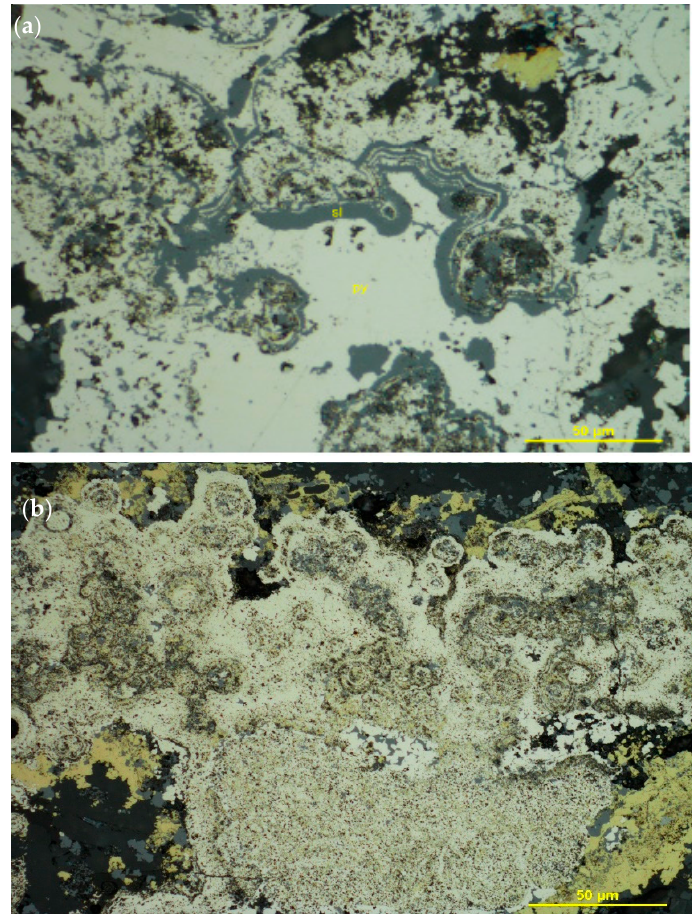
Figure 3. Very fine-grained crystals of pyrite (py) are intergrown with the sphalerite (sl) and define crustiform and layered intergrowths ( a ). Porous and spongy aggregates of pyrite define rounded framboidal aggregates and irregularly shaped domains associated with subordinate inclusion-free interstitial pyrite ( b ) from Ore B.